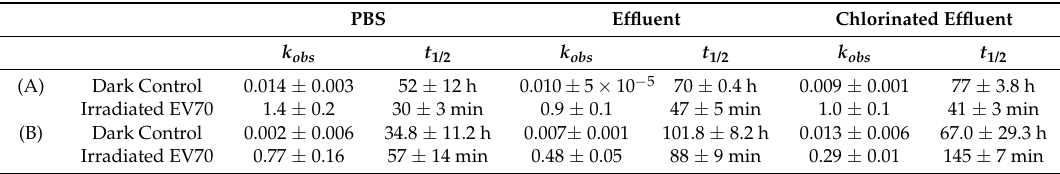
Table 1. Decay kinetic constants and half-life of ( A ) EV70 infectivity, and ( B ) RNA concentration, under simulated solar irradiation for 24 h in phosphate-buffered saline (PBS) (n = 3), effluent wastewater matrix (n = 2), and chlorinated effluent wastewater matrix (n = 2). k obs = decay constant. t 1/2 = half-life of